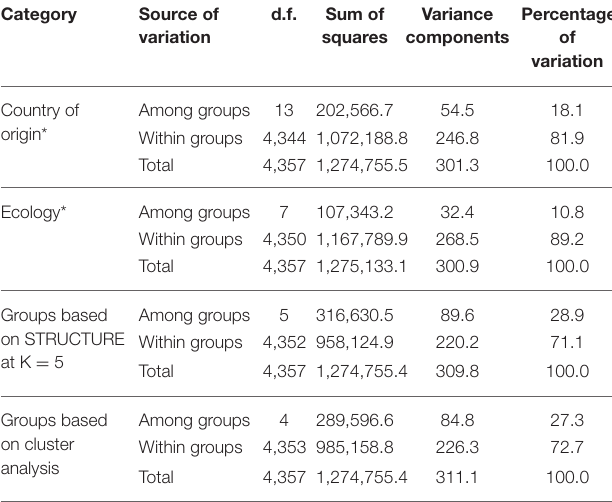
TABLE 4 | Analysis of molecular variance (AMOVA) for the extraction of SNP variation among and within groups (populations) based on 2,179 O. glaberrima accessions genotyped with 3,834 polymorphic